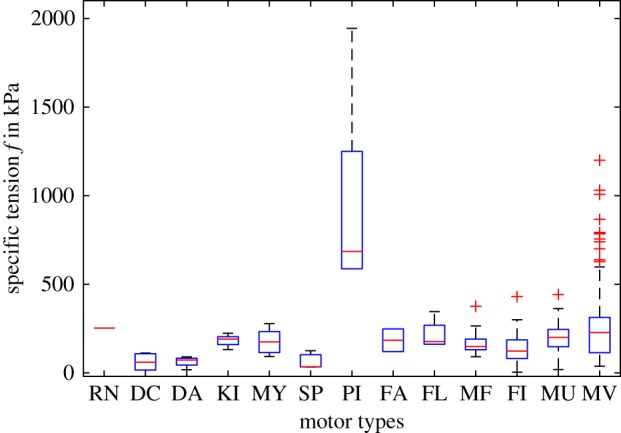
Boxplots of specific tensions per motor type (n = 349). The boxes extend from the lower quartile to the upper quartile values with the medians (red line) in between. The whiskers extend to the most extreme data values within 1.5 × IQR. Outliers (red crosses) are tensions beyond the end of the upper whiskers. Motor types: RN, RNA polymerase (n = 1); DC, cytoplasmic dynein (4); DA, axonemal dynein (4); KI, kinesin (7); MY, myosin (11); SP, spasmoneme (3); PI, pili (6); FA, F0/F1 ATPase (2); FL, flagellum (4); MF, myofibril (16); FI, muscular fibre (97); MU, muscle in vitro (89); MV, muscle in vivo (105). ANOVA and multiple comparison of means (electronic supplementary material, table S1, motor types with n < 5 removed: RN, DC, DA, SP, FA and FL): PI ≠ (KI, MY, MF, FI, MU, MV), FI ≠ MV and MU ≠ MV. Pili PI are significantly different from all other motor types.